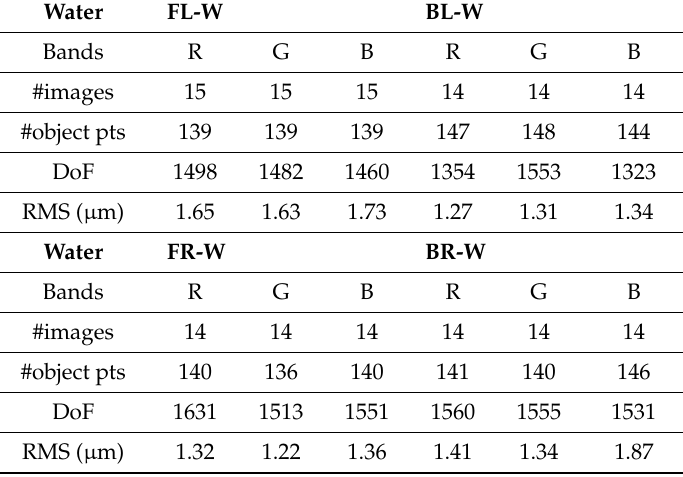
Table 3. Least square adjustment results of the independent (IDP) adjustment for all underwater datasets showing for each dataset the #images, #object points observed, the Degree of Freedoms (DoF) and the RMS values. Only one repeat of FL-W is shown. All other FL-W repeats achieved similar